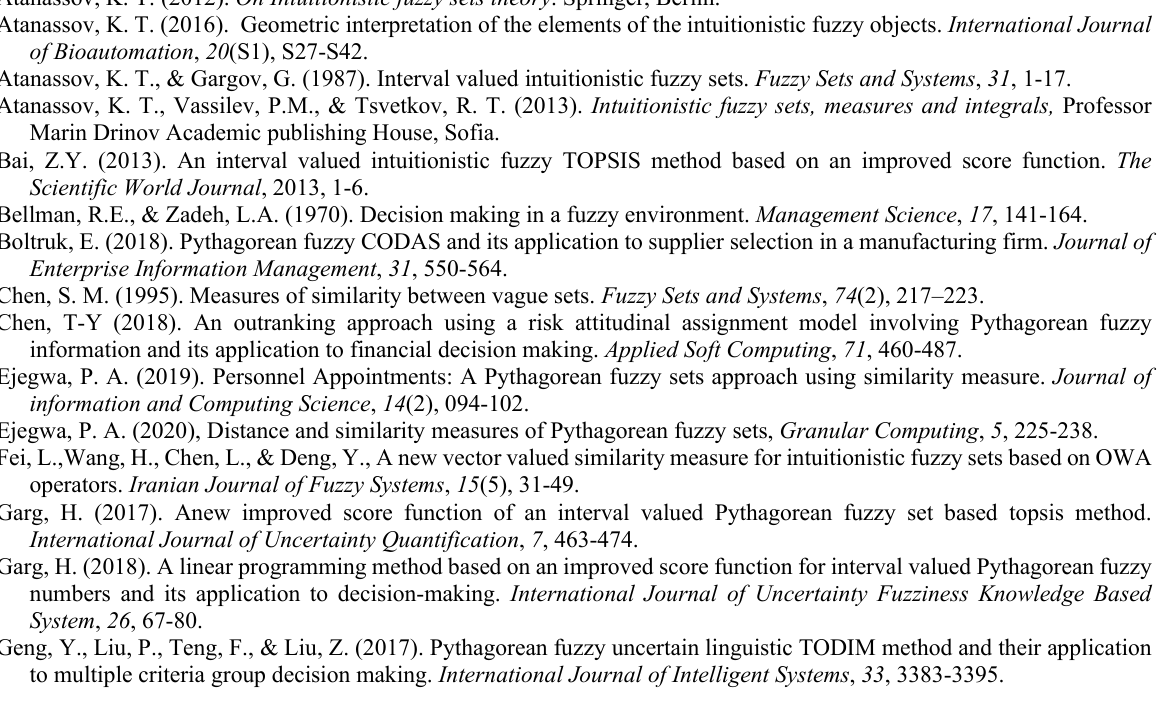
A 4 A 4 A 3 / A A 3 4 / A A 3 4 A 4 A 4 A 4